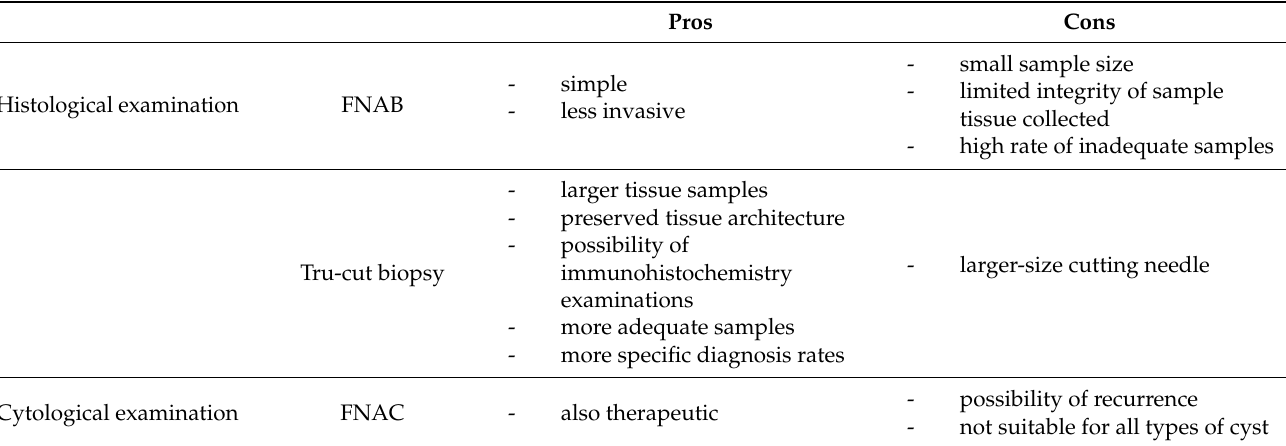
FNAB: fine needle aspiration biopsy; FNAC: fine needle aspiration